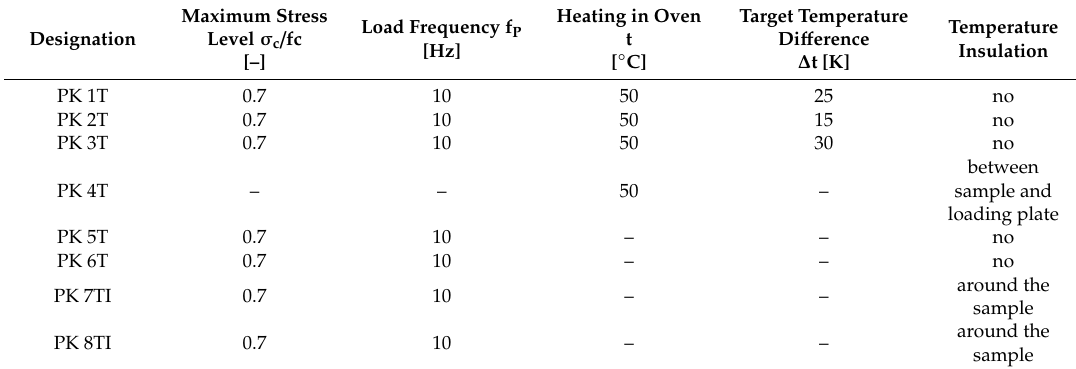
Table 1. Experimental program.